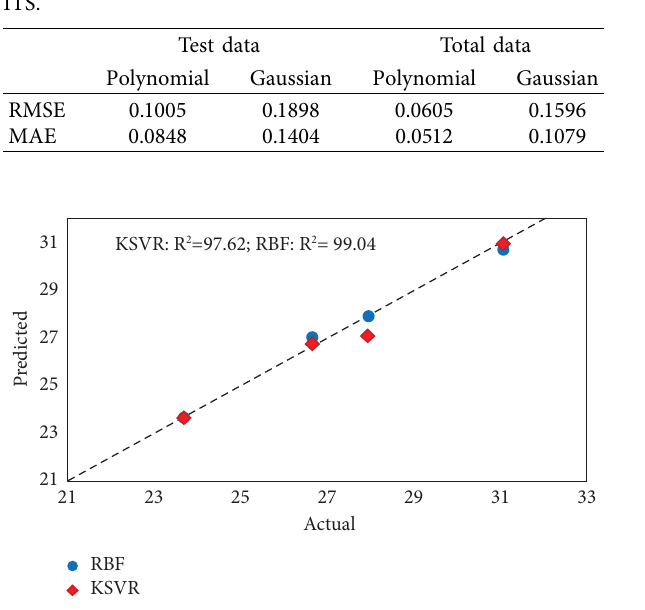
Figure 10: Actual and predicted values of CS by the RBF and KSVR models for test data.